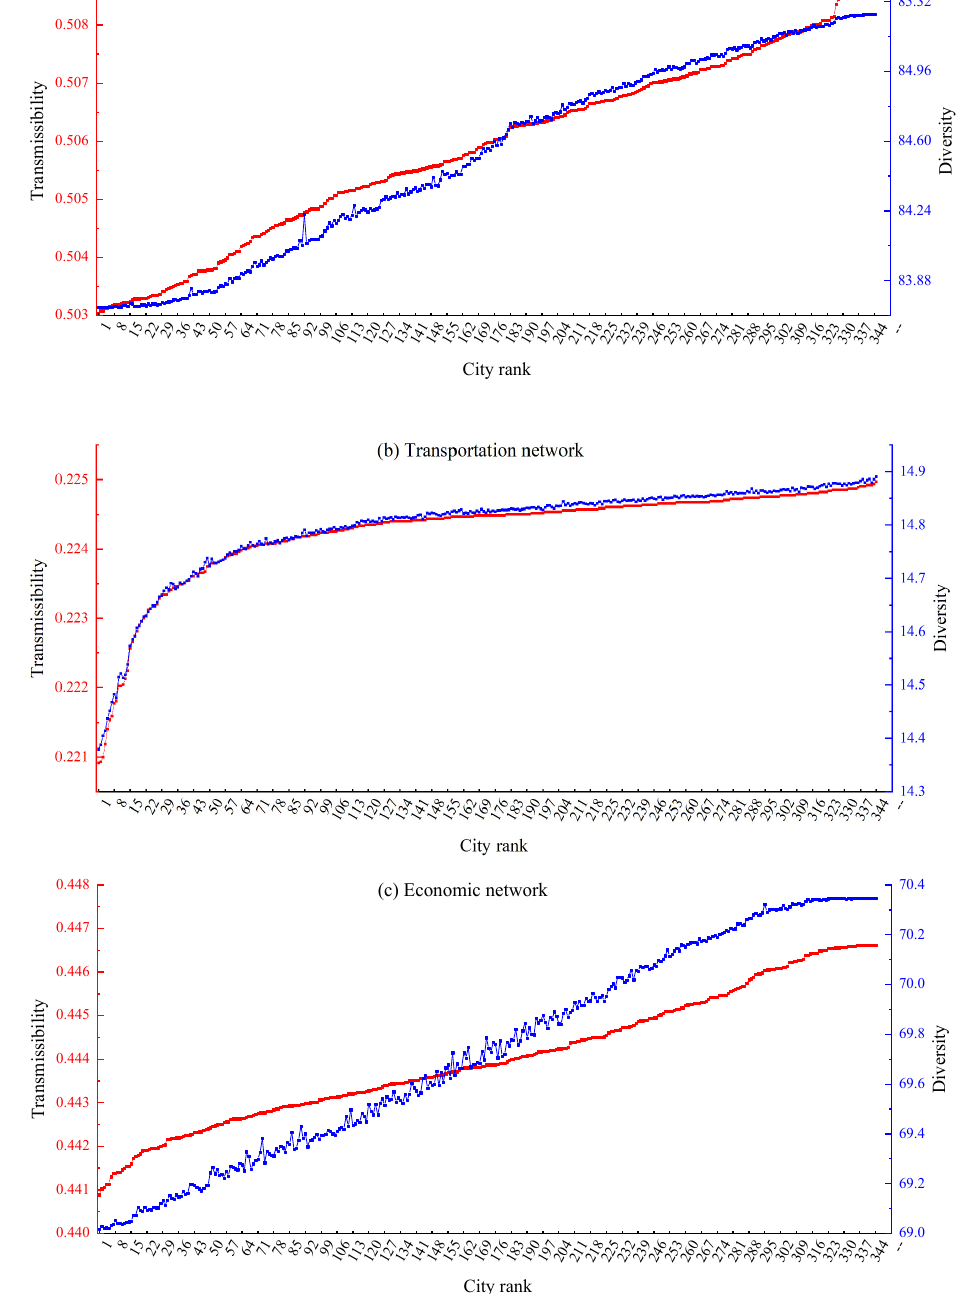
Figure 7. Changes of transmissibility and diversity in different networks after city failure: ( a ) information network; ( b ) transportation network; ( c ) economic network.